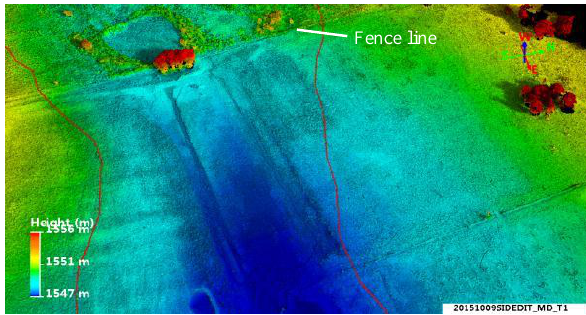
Figure 7. Point cloud (small extent 0.038 m) with height coloration and intensity enabled. The red line indicates the baseline delineation.